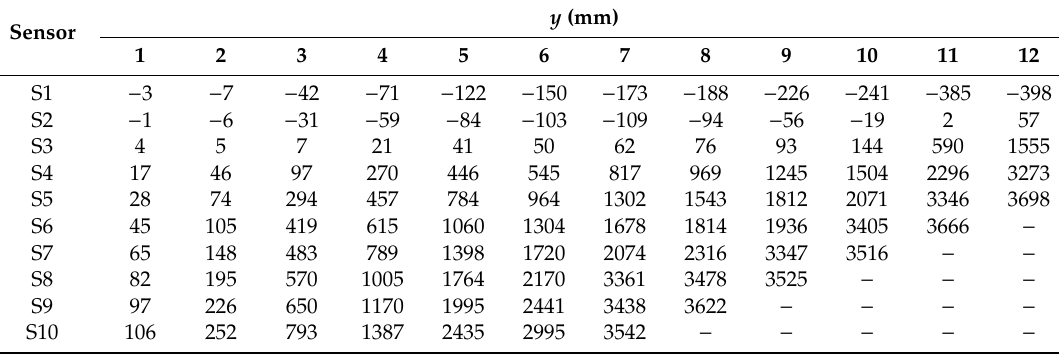
Table 13. The strain measurements in the area influenced by the joint in E8 (unit: mm).